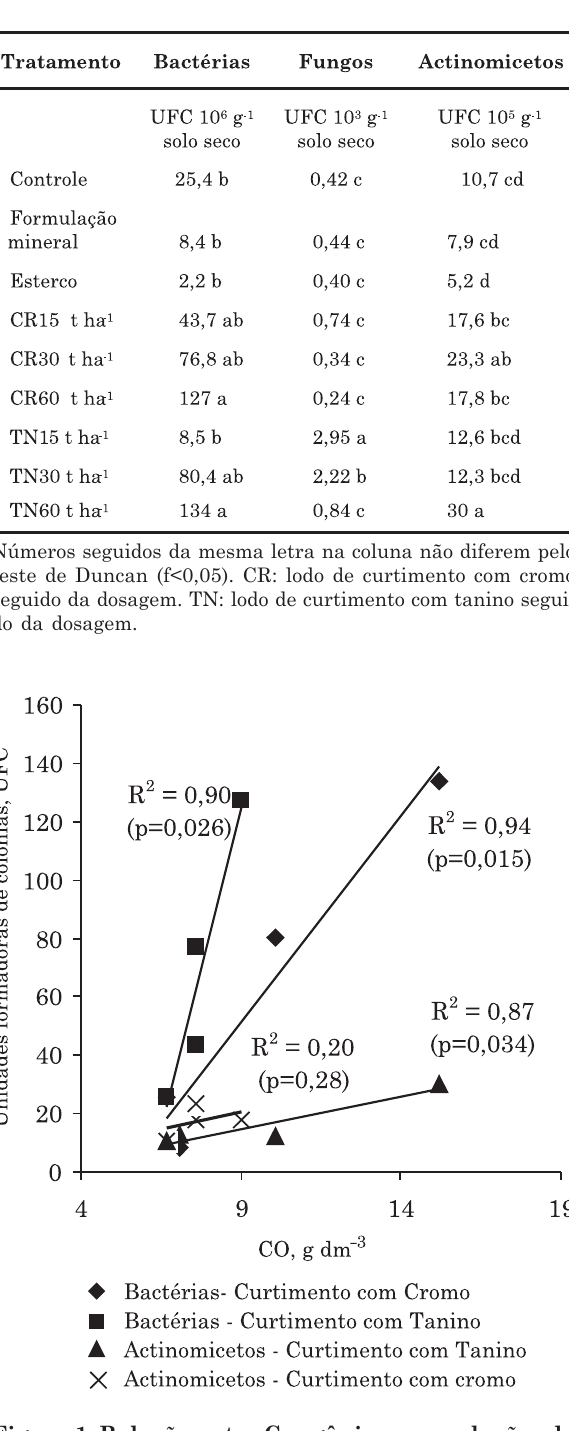
Figura 1. Relação entre C orgânico x populações de bactérias (UFC x 10 6 g -1 solo seco) e CO x populações de actinomicetos (UFC x 10 6 g -1 solo seco) sob solo incorporado com lodos de curtume (média de